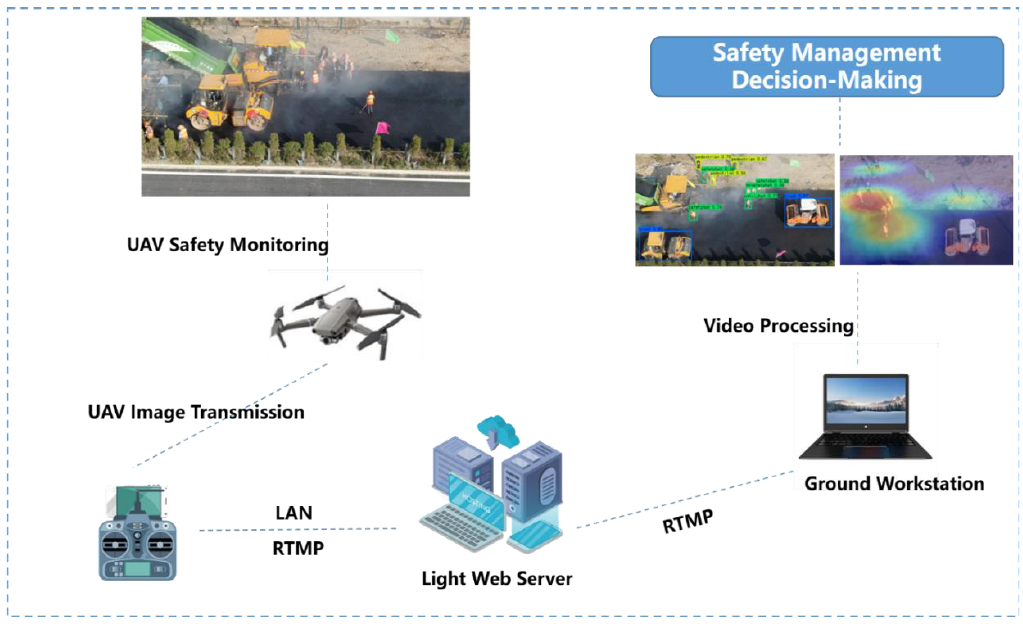
Figure 3. Implementation of UAV safety monitoring.